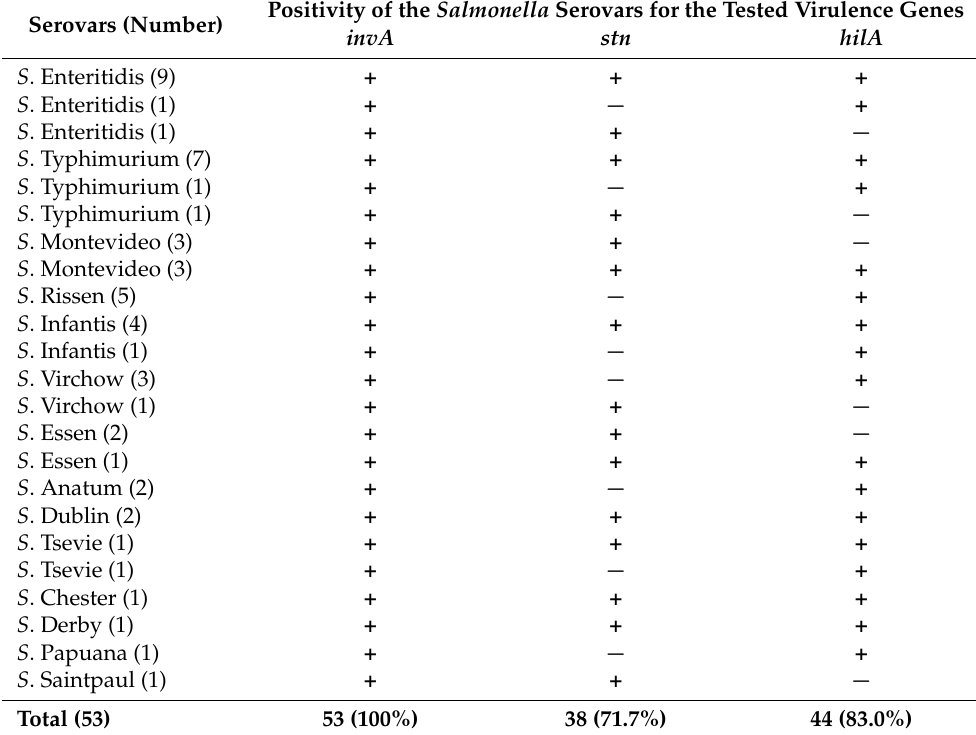
Table 1. Prevalence of the investigated virulence genes among the identified Salmonella serovars. Positivity of the Salmonella Serovars for the Tested Virulence Genes Serovars (Number) invA stn